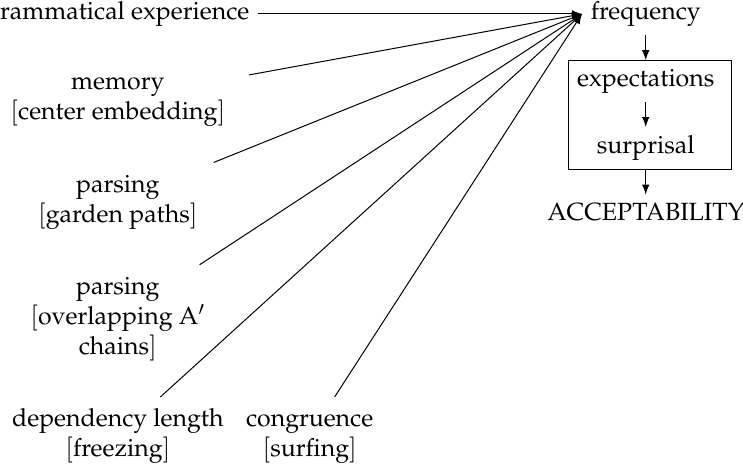
Figure 5. The logic of acceptability judgments for grammatical conditions, version